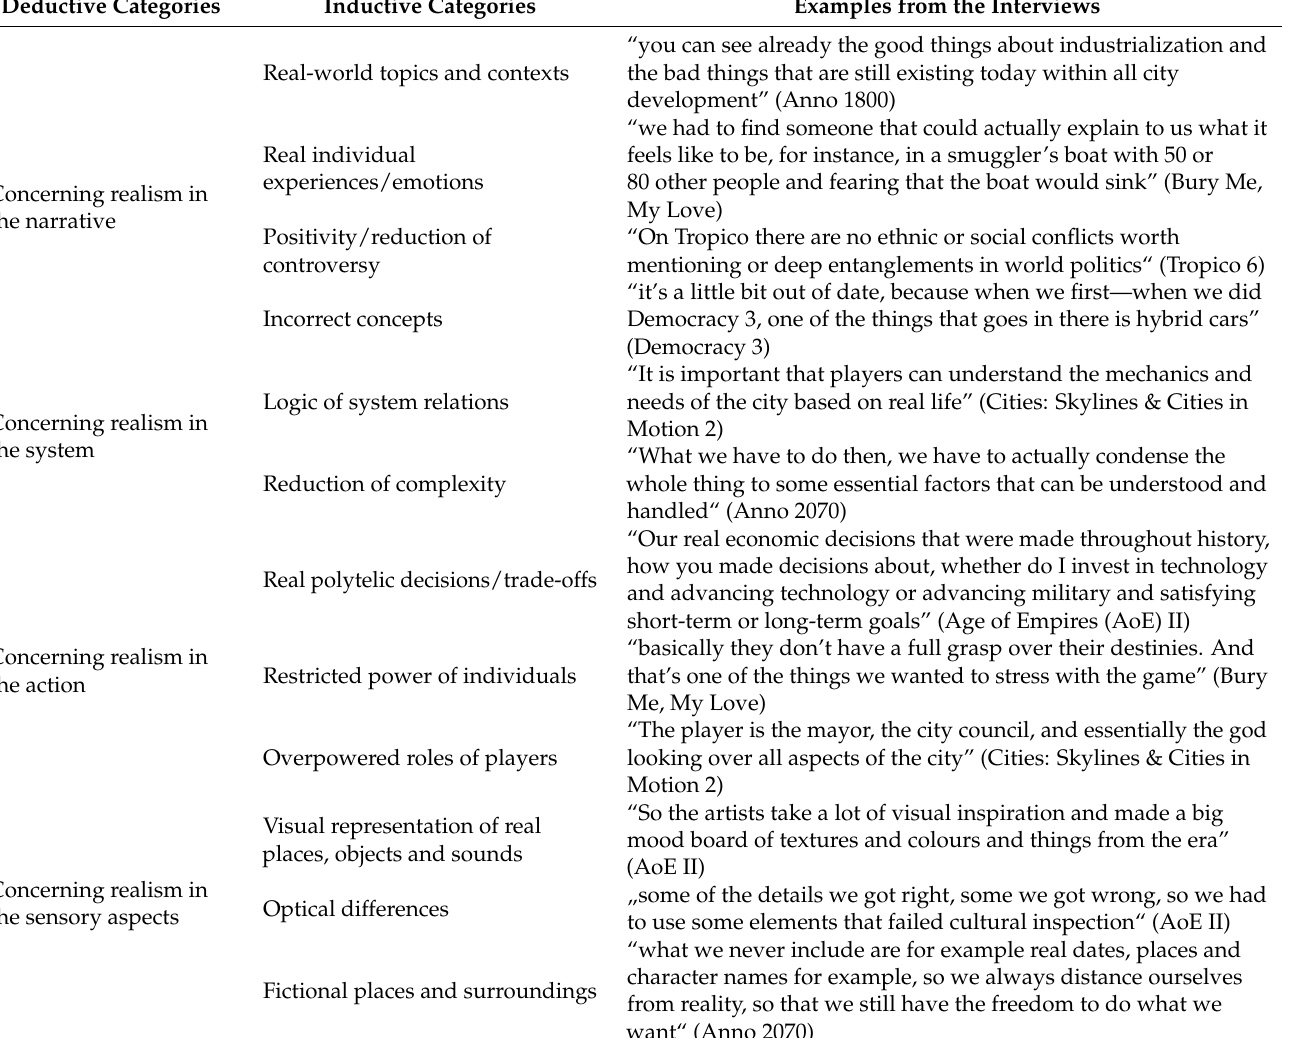
Table 2. Linking of deductive and inductive categories in our interview